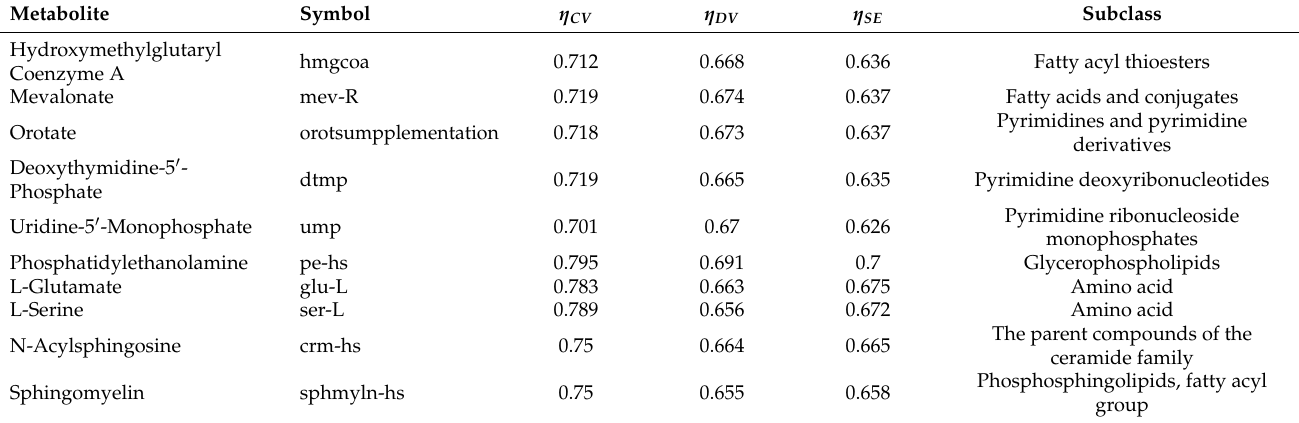
Table 3. Membership grades of cell viability ( η CV ), metabolic deviation ( η DV ), and side effect ( η SE ) for the top 10 one-target antimetabolites determined by the IACT